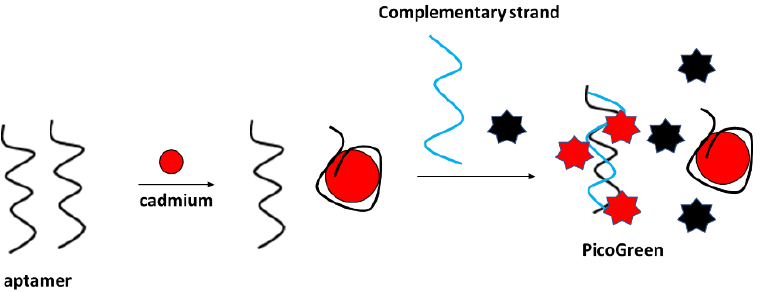
Figure 25. The sensing principle scheme of the fluorescence aptasensor towards cadmium ion based on PicoGreen indicator selectively interacting with double-stranded DNA.